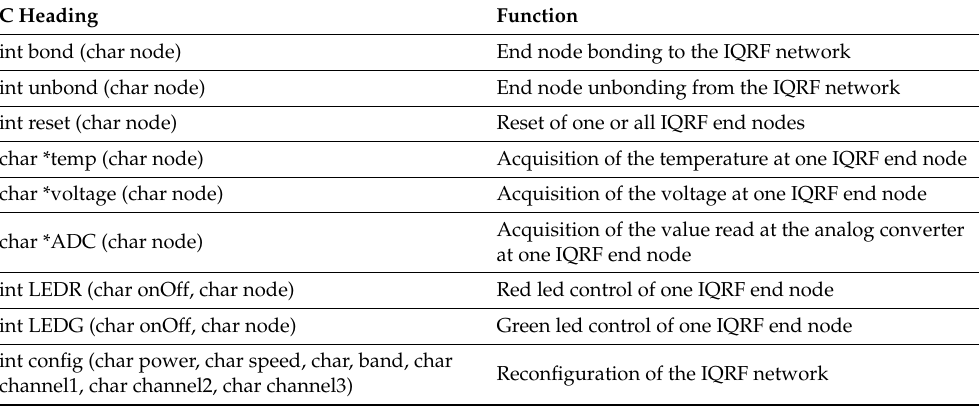
Table 3. C bindings for controlling the IQRF network from the Raspberry Pi.